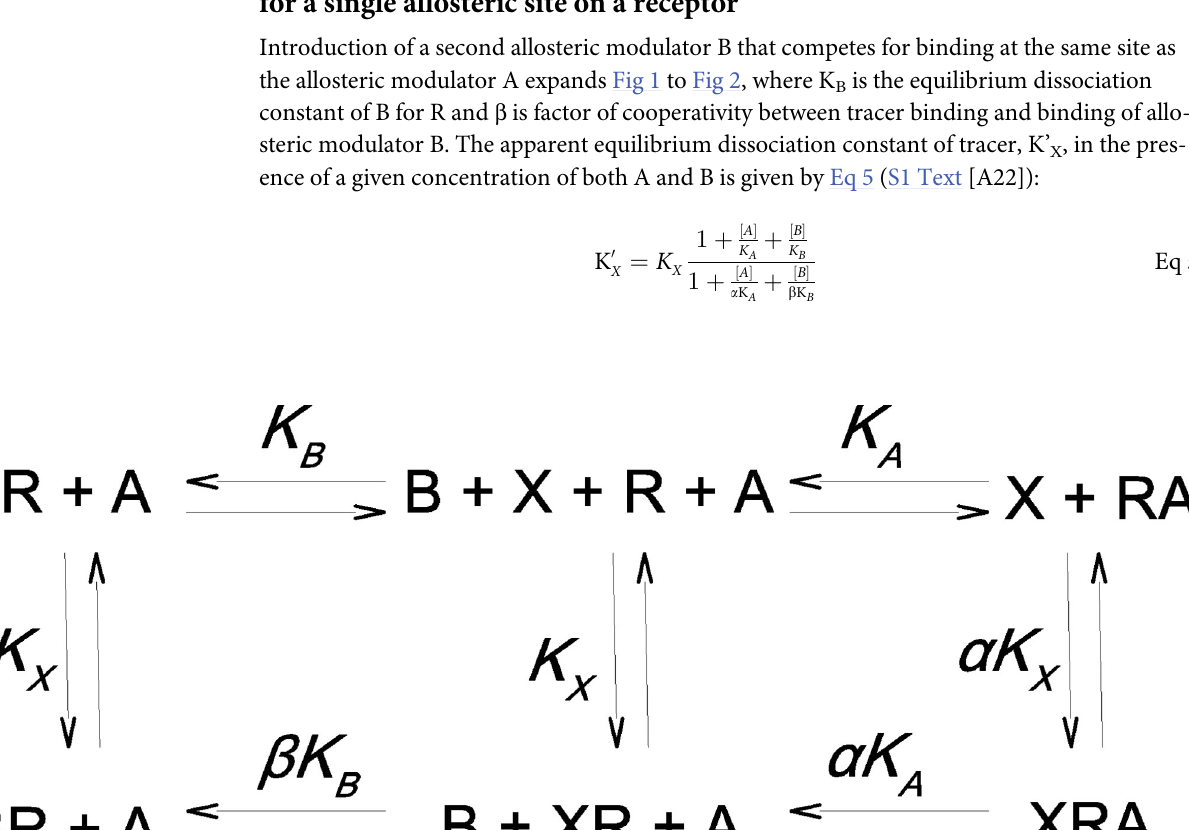
PLOS ONE | https://doi.org/10.1371/journal.pone.0214255 March 27,